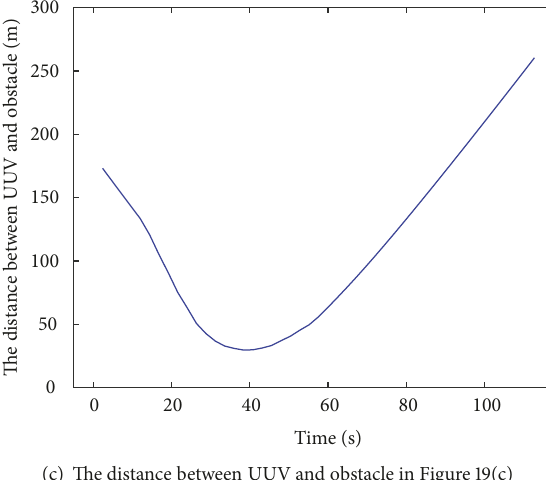
(a) The distance between UUV and obstacle in Figure 19(a) (b) The distance between UUV and obstacle in Figure 19(b)